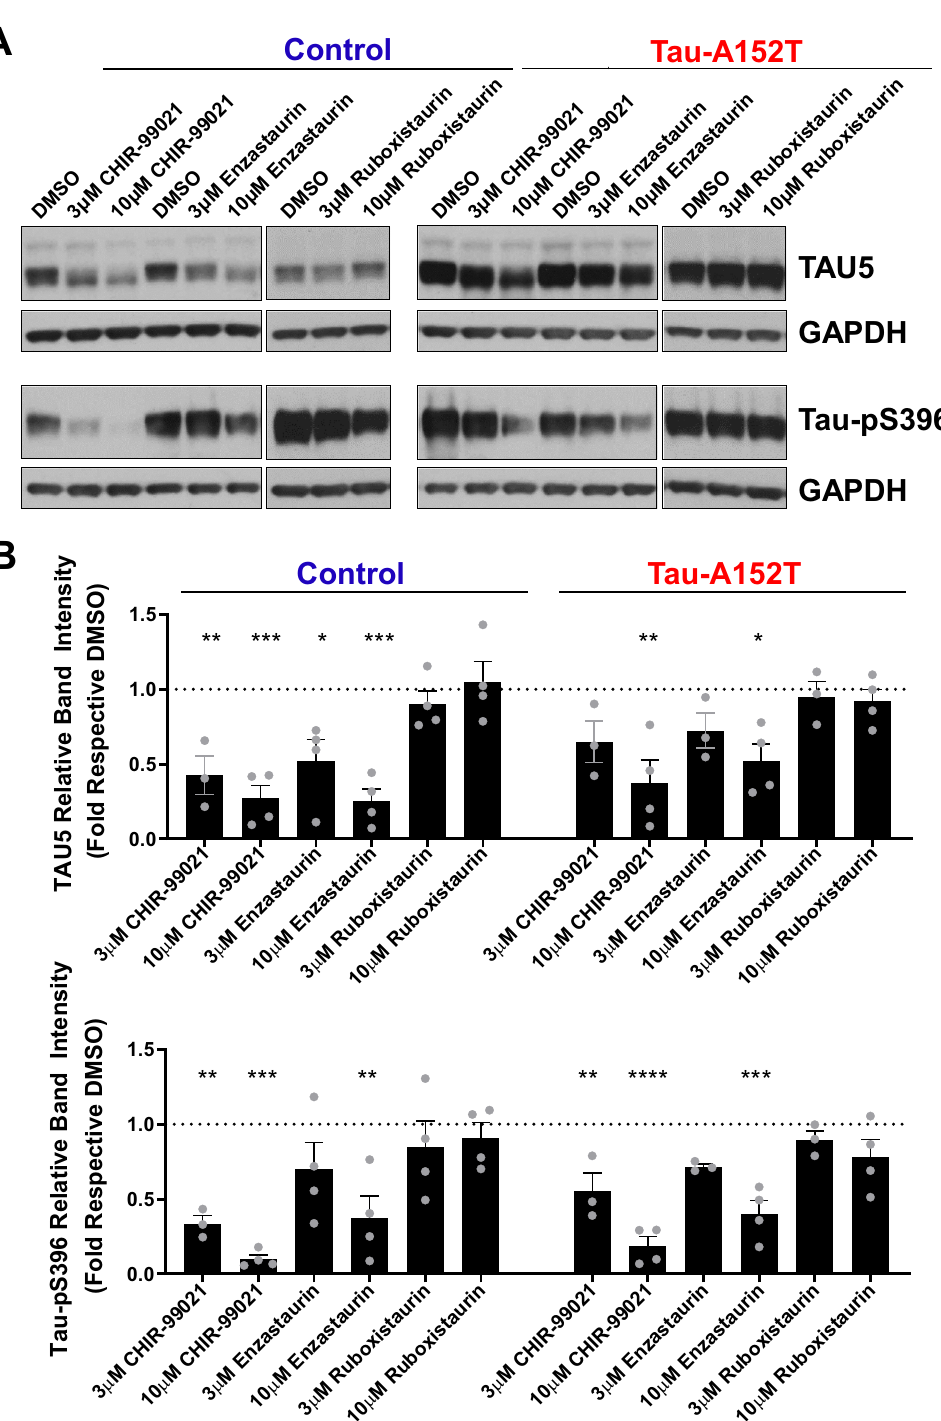
Figure 7. Effect of compounds on tau protein levels. Representative western blot images ( A ) from one of 3–4 replicate sets collected per compound. Full-length blots are presented in Supplementary Fig. S12. ( B ) Quantitation of western blot band intensities showing the effect of 20 h treatment with CHIR-99021, enzastaurin or ruboxistaurin on TAU5 and Tau-pS396 in both control and Tau-A152T iNgn2 neurons. Each bar represents mean ± SEM of at least 3 biological replicates; dots represent individual values. TAU5 and Tau-pS396 band intensities were normalized to GAPDH band intensities to control for variation in sample loading. To account for blot to blot variability in signal intensity, band intensities for drug treatment lanes were normalized to the DMSO band intensity of each cell line in each blot. The dotted line represents the GAPDH-normalized signal intensity of DMSO, set to 1. One-way ANOVA, Dunnett’s post hoc test, *p ≤ 0.05, **p ≤ 0.01, ***p ≤ 0.001, ****p ≤ 0.0001 compared to